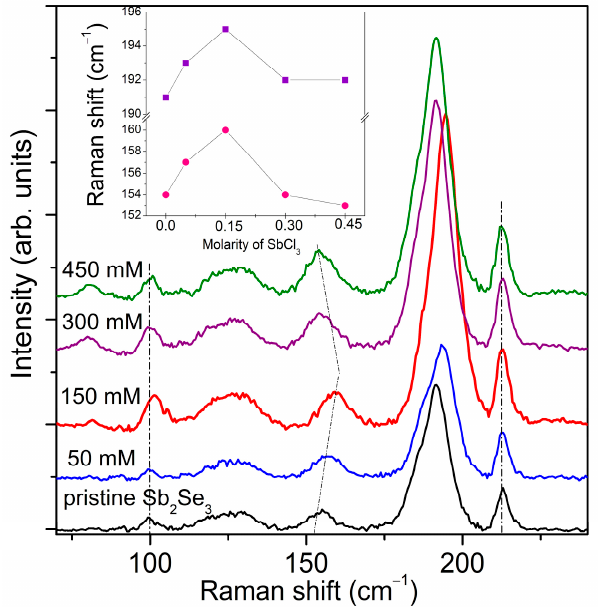
Figure 3. Raman spectra of the pristine Sb 2 Se 3 film and those thermally treated in glycerol at various concentrations of SbCl 3 for 90 min at 300 °C.